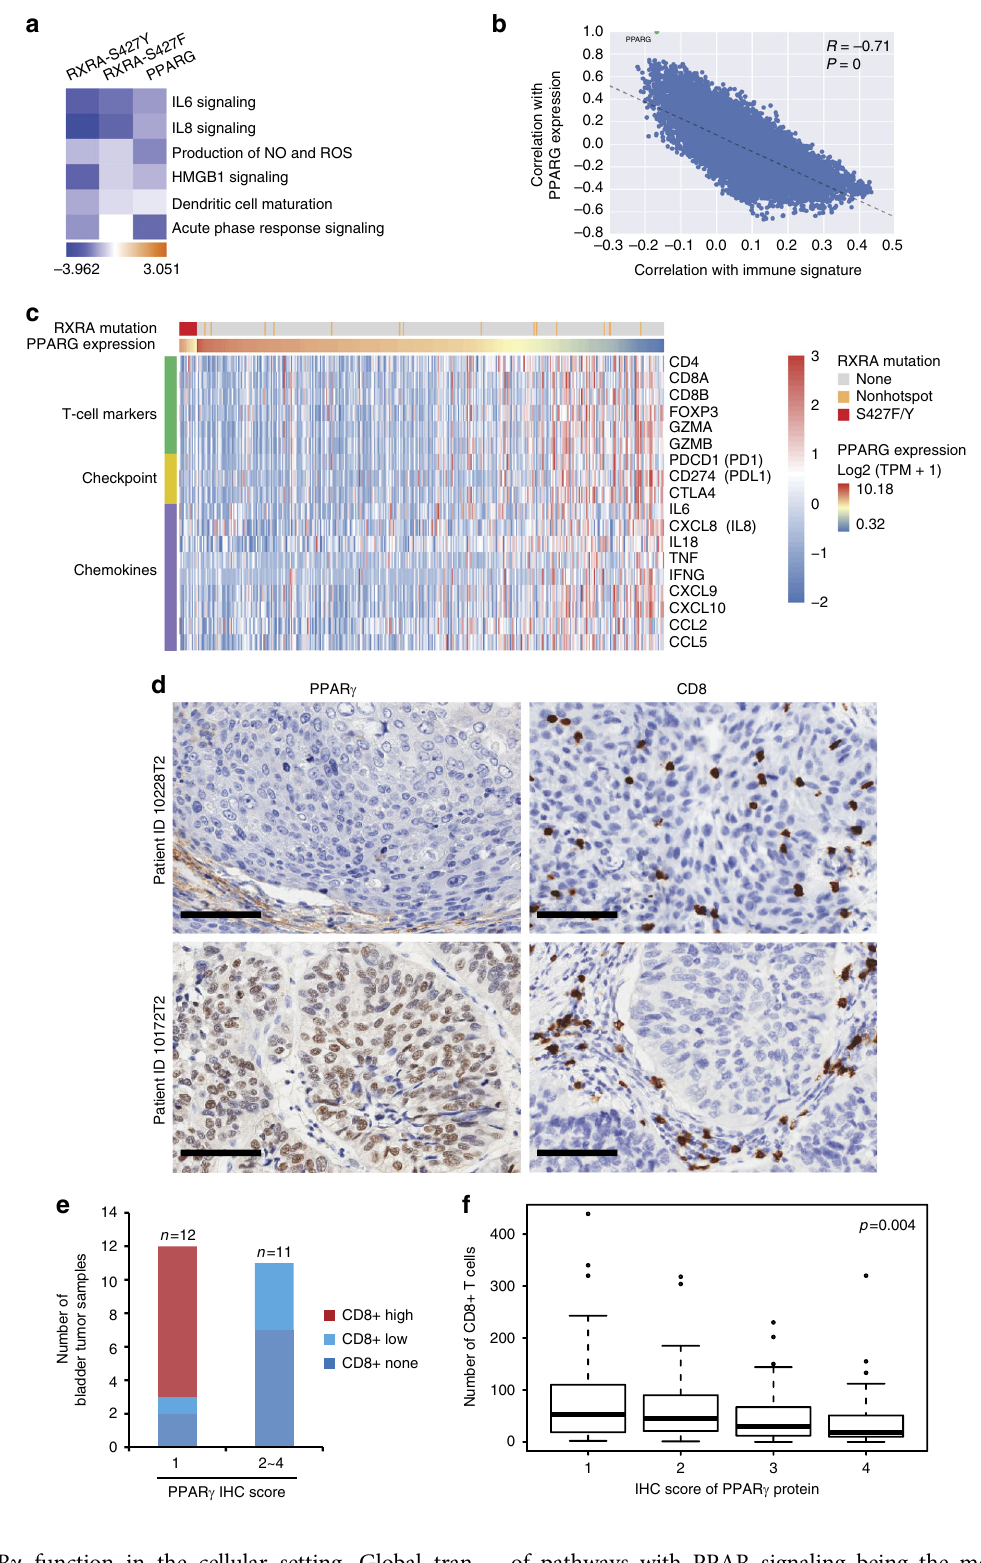
promote PPAR γ function in the cellular setting. Global tran- scriptome pro fi ling revealed a signi fi cant overlap of differentially expressed genes between the PPAR γ , RXR α S427F and RXR α S427Y overexpressing human bladder cancer lines relative to their respective controls (Fig. 3a, Supplementary Fig. 9). Furthermore, as we observed in the TCGA MIBC data set (Supplementary Fig. 4), all three genetic alterations commonly regulated a number